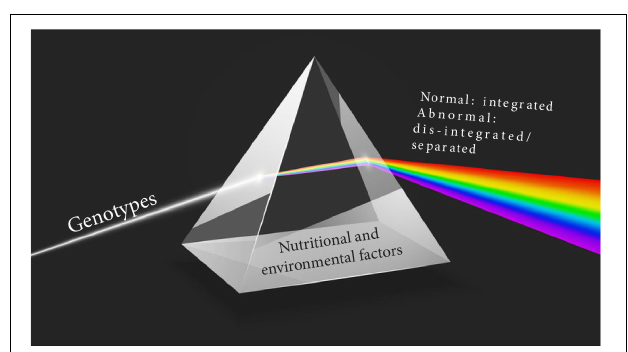
FIGURE 4 | Schematic representation of the interaction between environmental factors and clinical